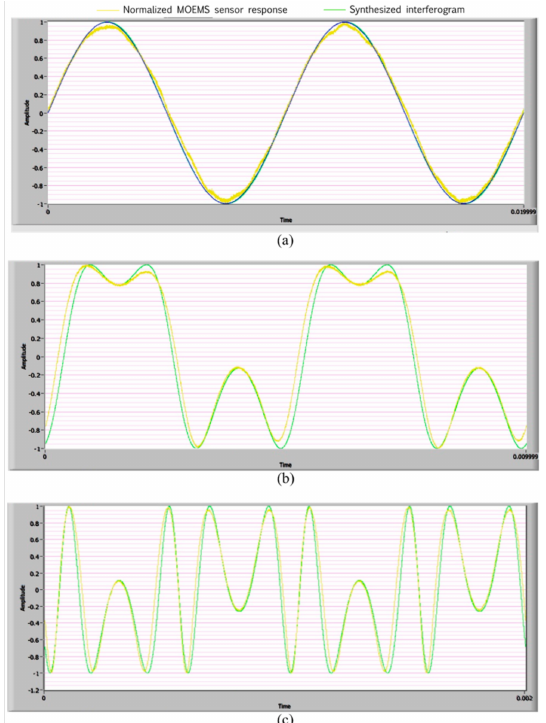
Figure 13. Normalized sensor response (yellow plot) and synthesized interferogram (green plot). ( a ) Sinusoidal output for an acceleration input with a sufficiently small amplitude. ( b ) Distorted sinusoidal output for an acceleration input of 20 m/s 2 at f = 200 Hz and ( c ) f = 1000